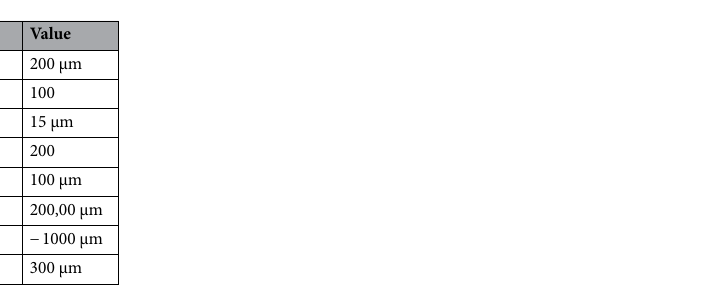
Table 1. Geometrical parameters of the NEURON model for an Aplysia neuron that contains a soma and an axon.